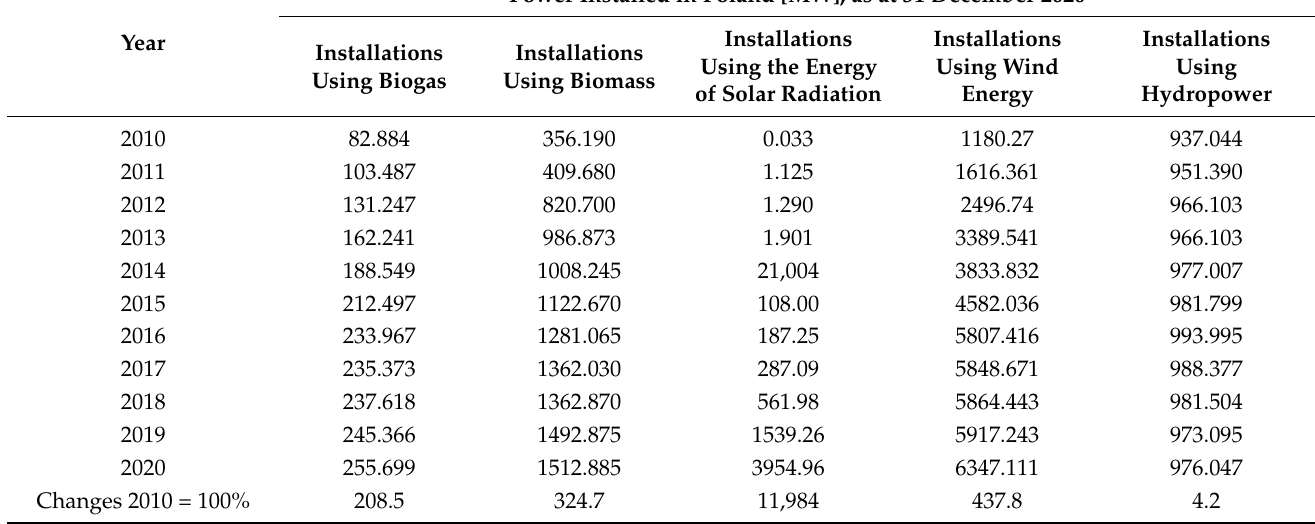
Table 2. Power of installed capacity in Poland